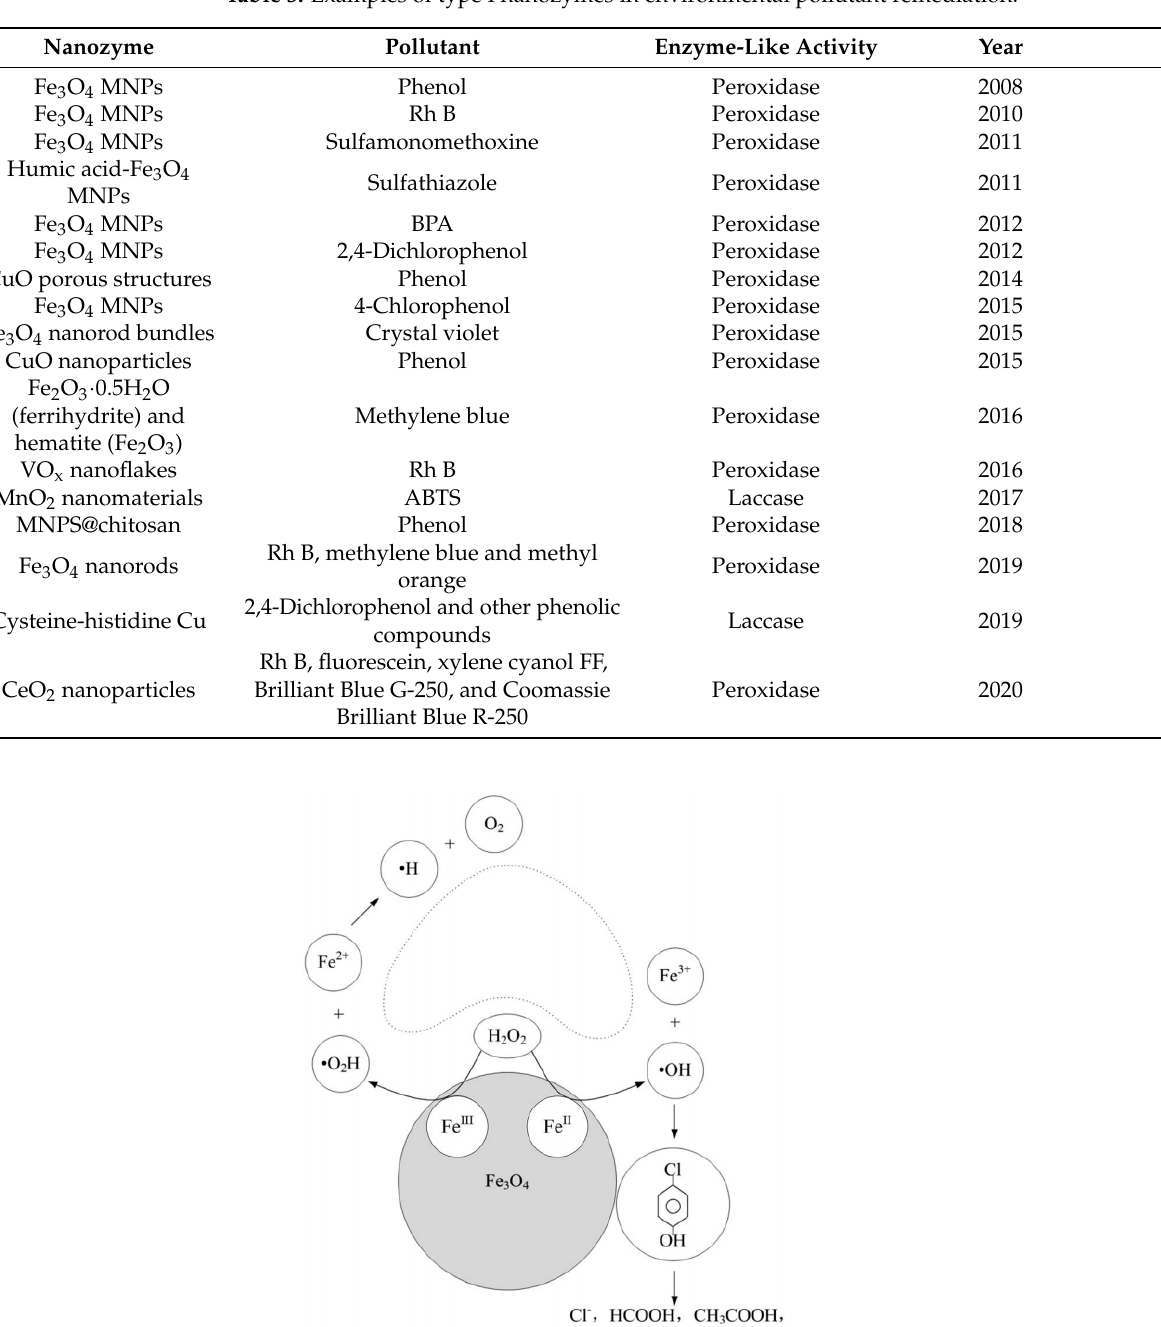
Table 3. Examples of type I nanozymes in environmental pollutant remediation.